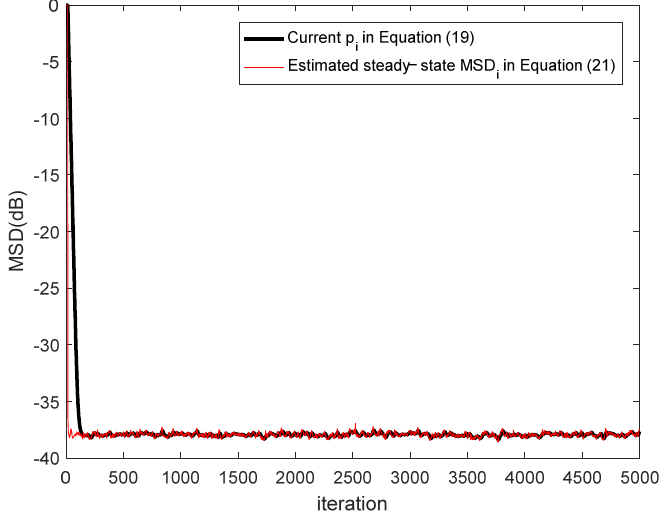
Figure 1. Convergence plots of the current p i and steady-state MSD values (SNR = 30 dB, M = 16, K =